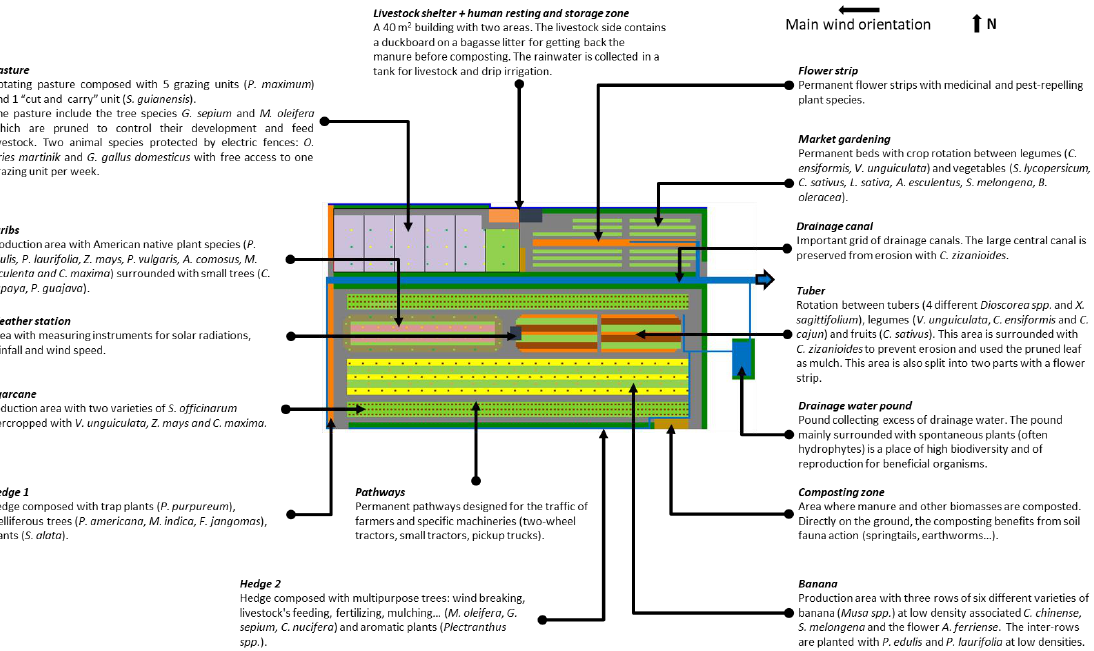
Figure 2. Overview of the AEMF structure experimented at the research institute.